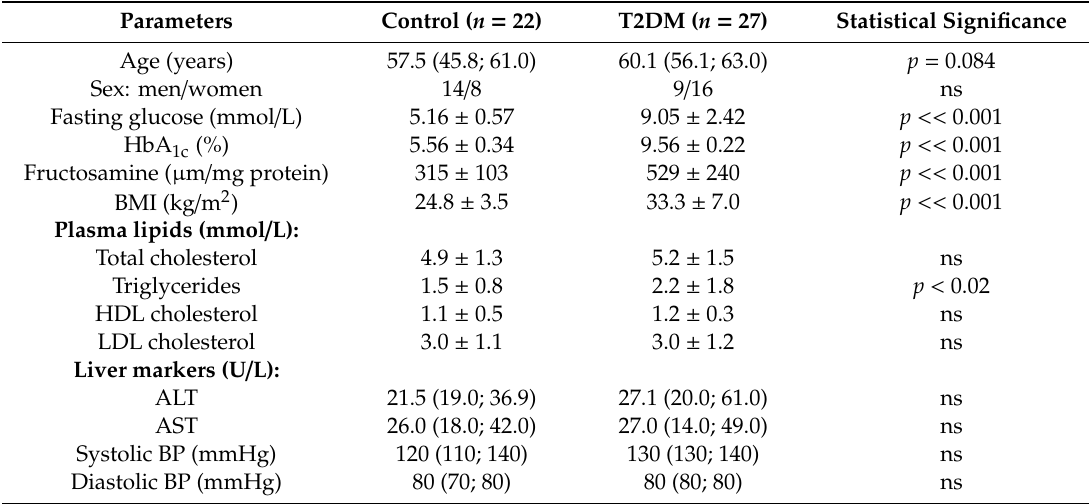
Table 1. Characteristics of type 2 diabetes mellitus (T2DM) patients and control